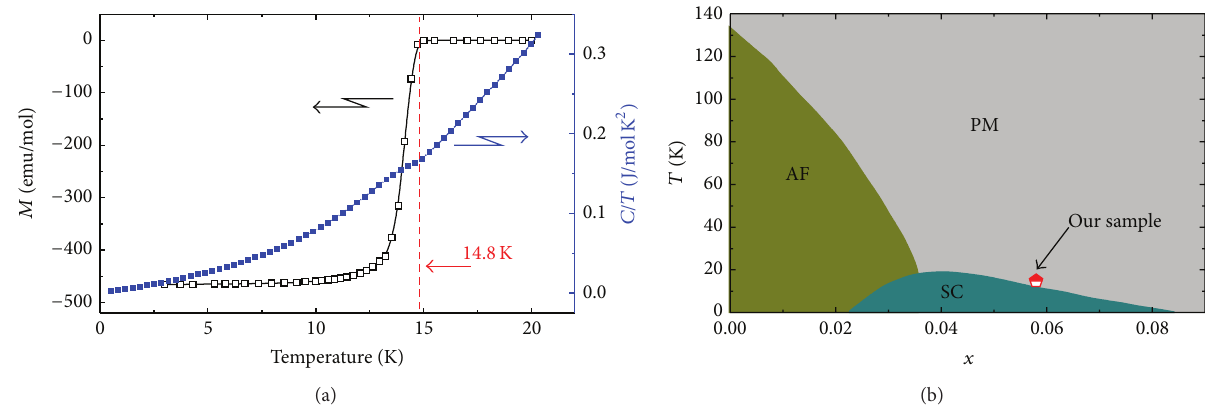
Figure 2: (a) Temperature dependence (color online) of dc magnetization (left) and specific heat coefficient 𝐶/𝑇 (right) for the sample. The magnetization data are collected with field 𝐻 = 10 Oe using the zero field cooling (ZFC) process. (b) Phase diagram for the Ni-doped 122 system [32]. The red mark shows the location of our sample.